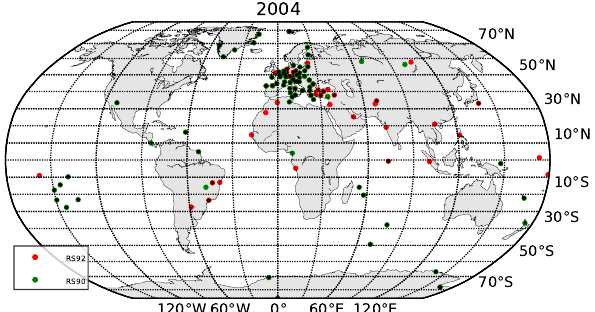
Figure 2. Same layout as Fig. 1, but for 2011. In addition, GRUAN stations with data available in this year are marked in blue. The four GRUAN stations discussed in Sect. 3.4 are marked with an orange